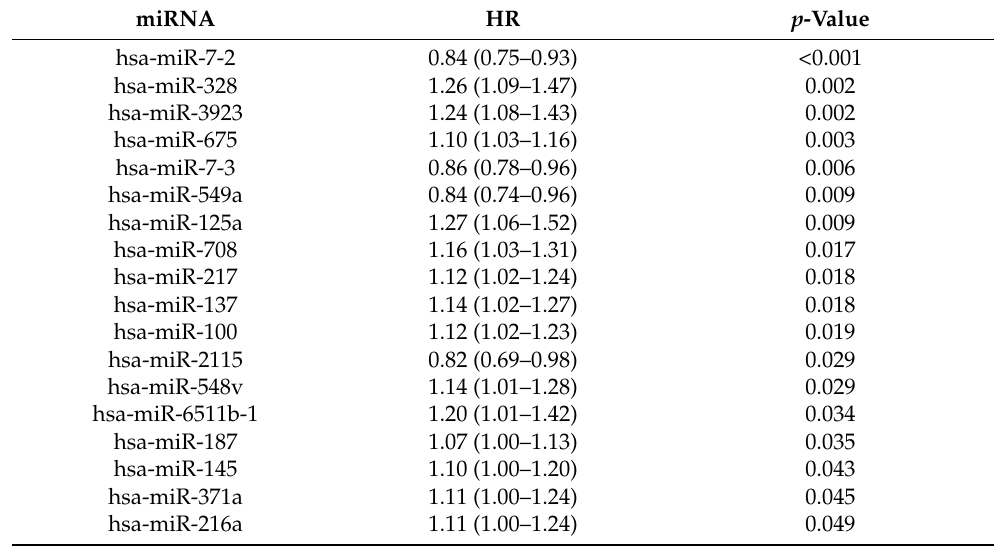
Table 1. Univariate Cox regression analysis of the 18 miRNAs associated with survival in GC patients. miRNA HR p